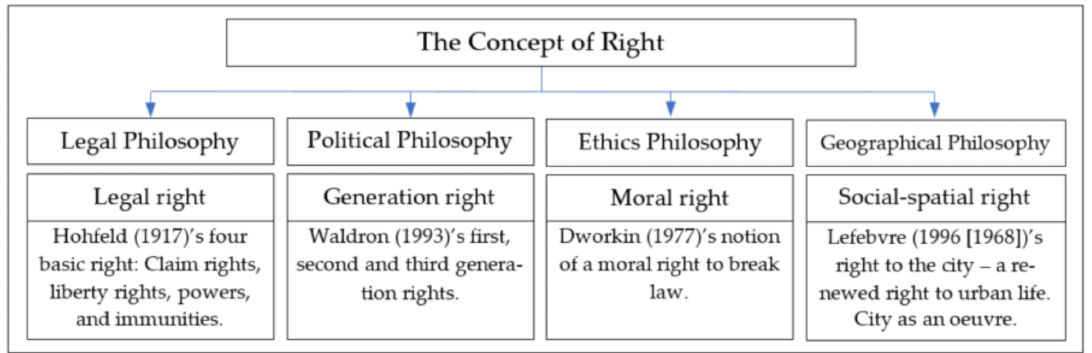
Figure 1. The concept of